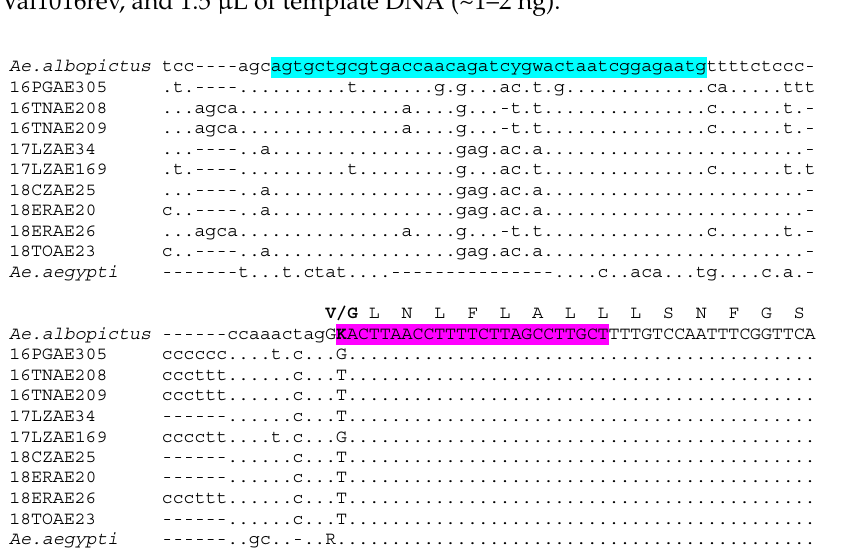
Figure 1. Partial alignment of domain II of the voltage-sensitive sodium channel genes of Ae. aegypti and Ae. albopictus . Intronic sequences are shown in lower case and mutation V1016G in bold in both the nucleotidic sequence and the above amino acidic sequence. Purple: primer binding site of allele-specific reverse primers. Light blue: position of the newly designed primer Albo1016for. Thermocycler conditions included a pre-incubation step for optimal UNG activity at 37 ◦ C for 5 min, followed by an initial DNA denaturation step at 94 ◦ C for 2 min. Afterward, 35 cycles at 95 ◦ C for 30 s, 54 ◦ C for 30 s and 72 ◦ C for 20 s were employed with a final elongation at 72 ◦ C for 3 min. PCR amplification products were loaded onto a 3% agarose gel stained with 6.5 µ L Midori Green Advance (Nippon Genetics, Tokyo, Japan) and run for 30–40 min at 85 V in 1xTBE buffer. The assay produced a ~90 bp fragment for the wildtype